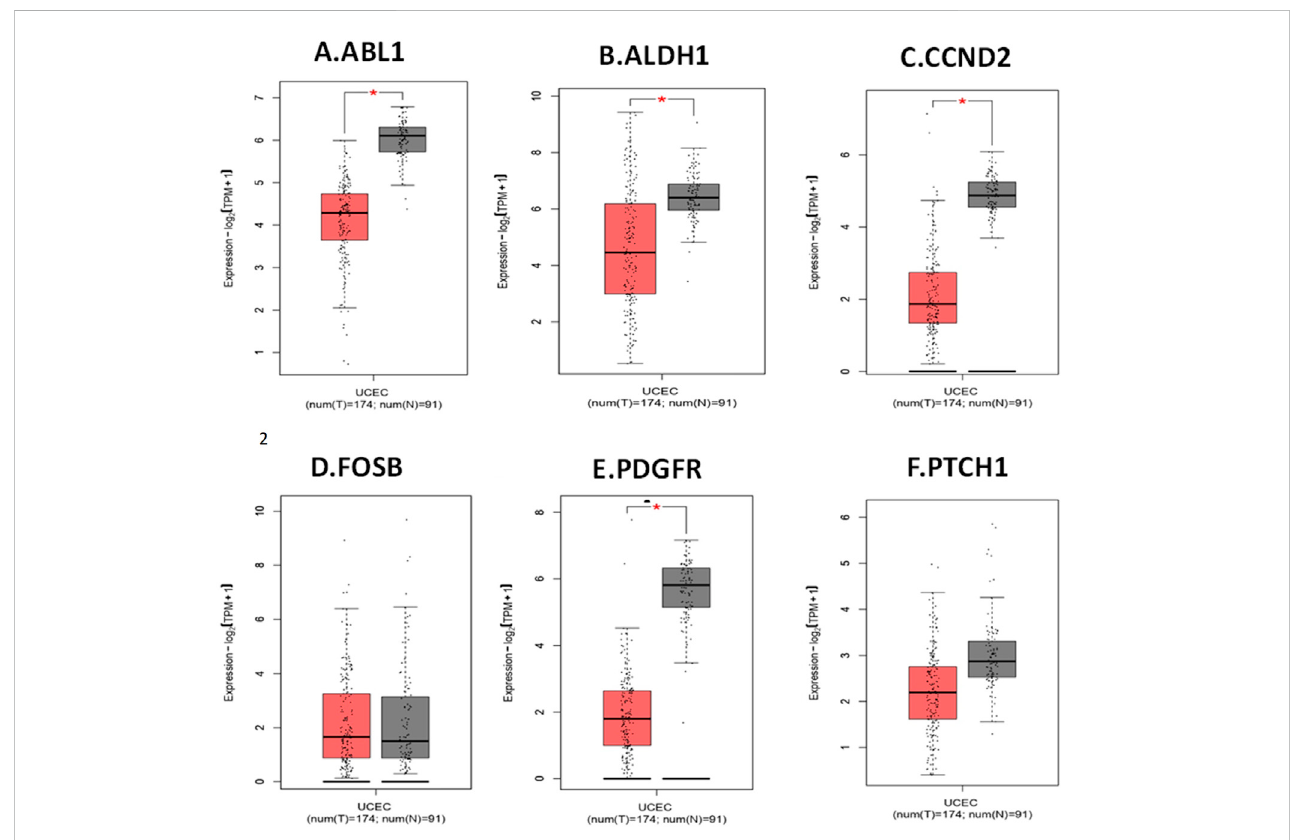
FIGURE 5 Expression pro fi le of hub genes in endometrial cancer compared to normal tissue (from GEPIA2). (A). ABL1 . (B). ALDH1A1 . (C). CCND2 . (D). FOSB . (E). PDGFRA. (F). PTCH1 .TheY-axisdeterminethemeanvalueoflog2(TPM+1;Log2FC > 1; p -value < 0.01).X-axisdeterminethesamples.Theredboxrepresents EC samples, while the gray box represents normal tissues. Each dot represents an individual sample in the